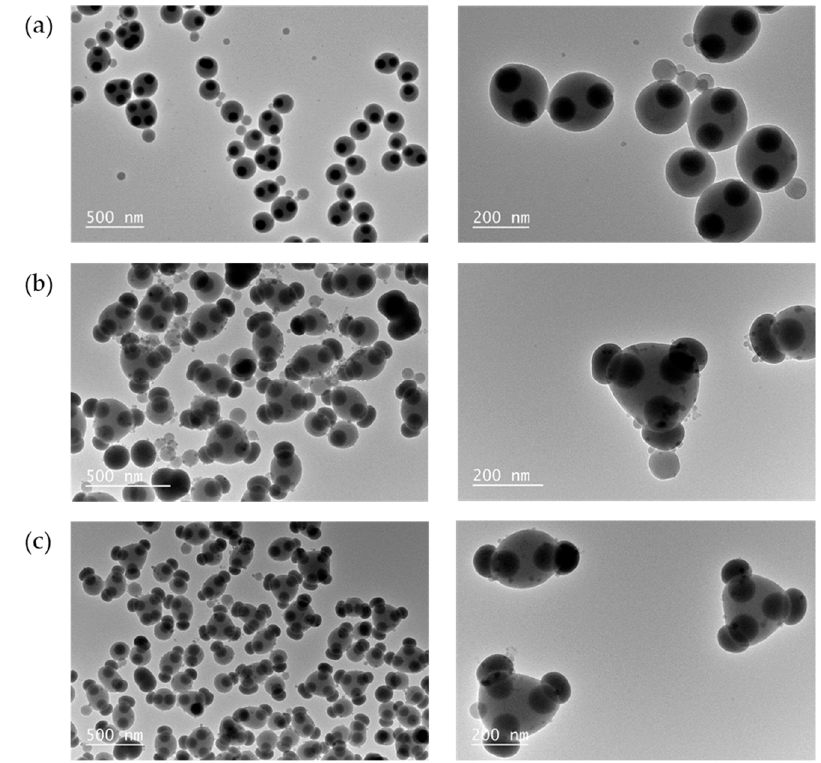
Figure 7. Representative TEM images of ( a ) PS particles with silica patches as obtained according to experimental conditions described in Table 2, entry #2.7; ( b ) the same particles after silica regrowth; and ( c ) the particles obtained after assembly in similar conditions of the silica/PS monopods after silica regrowth.